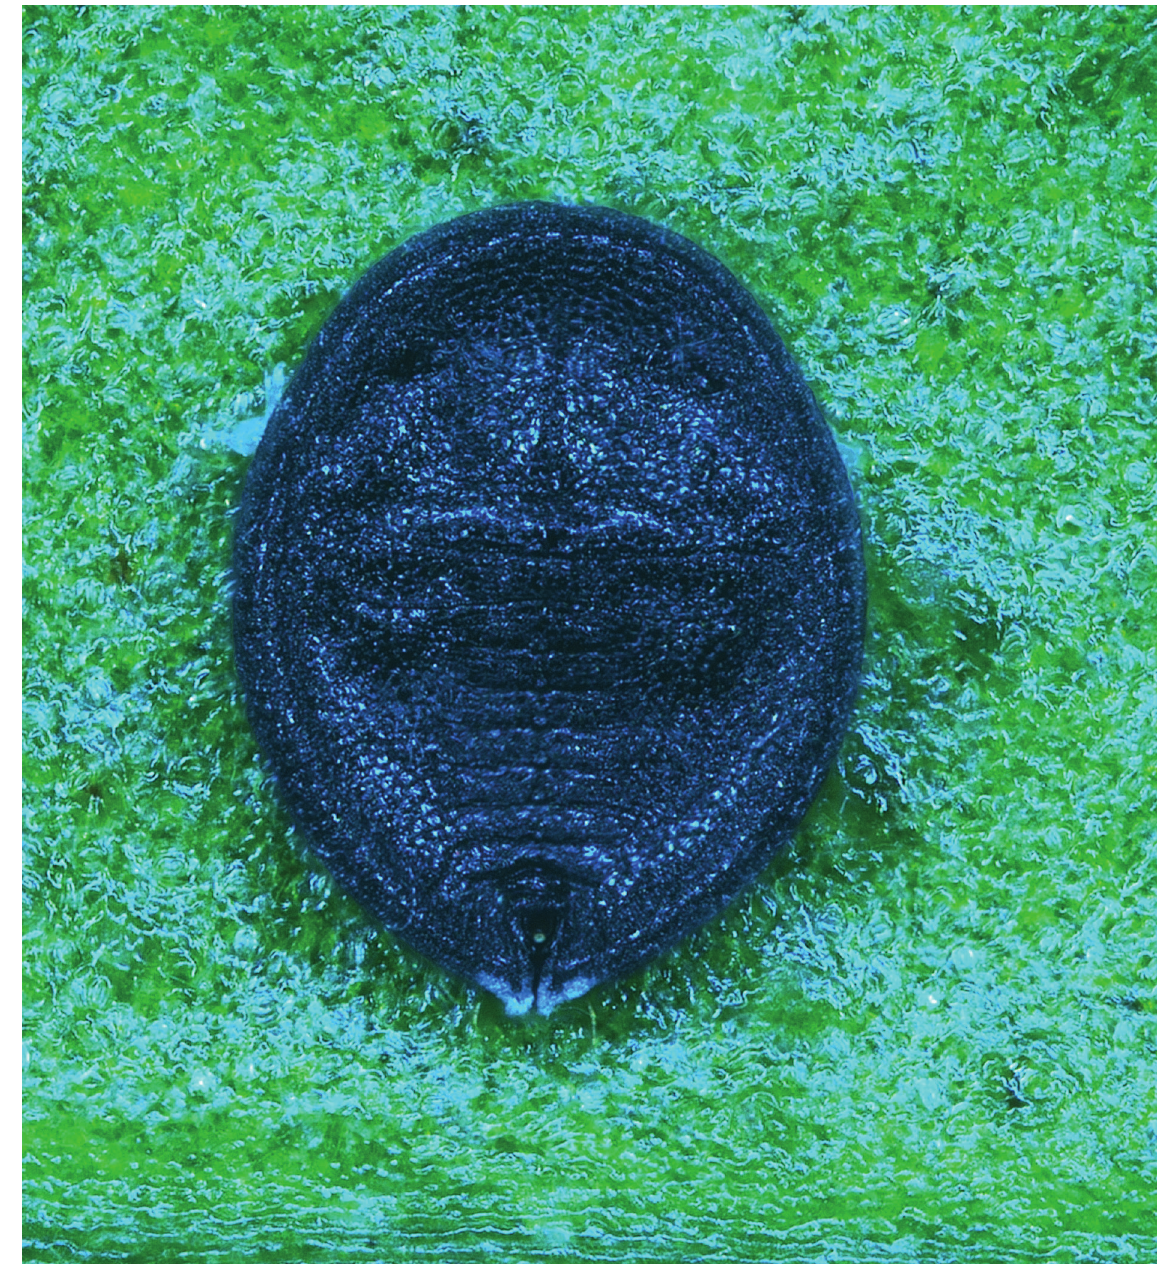
Fig. 2. Rudisculptus caudalis gen. et sp. nov., puparium, paratype (ANRC-ZSI), habitus on